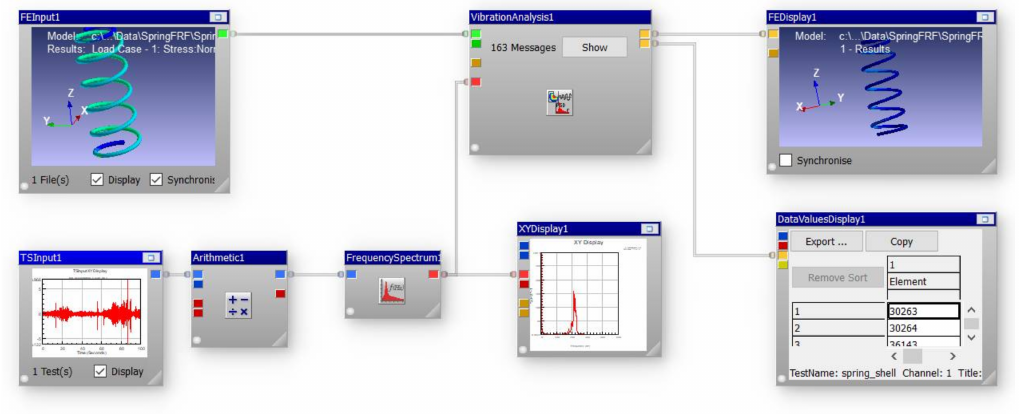
Figure 3. Vibration fatigue analysis using nCode ® Designlife ®